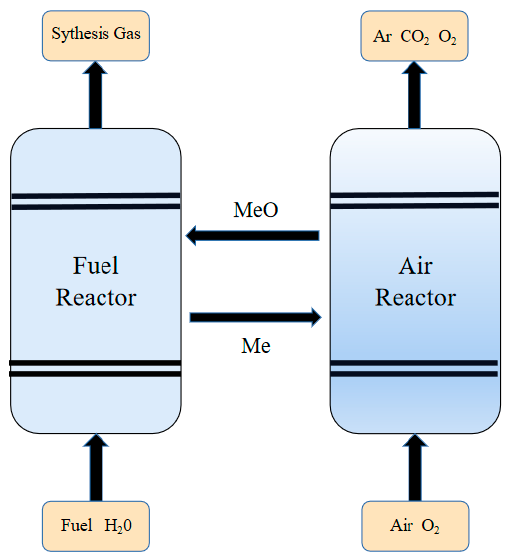
Figure 1. A schematic diagram of the chemical looping gasification process.